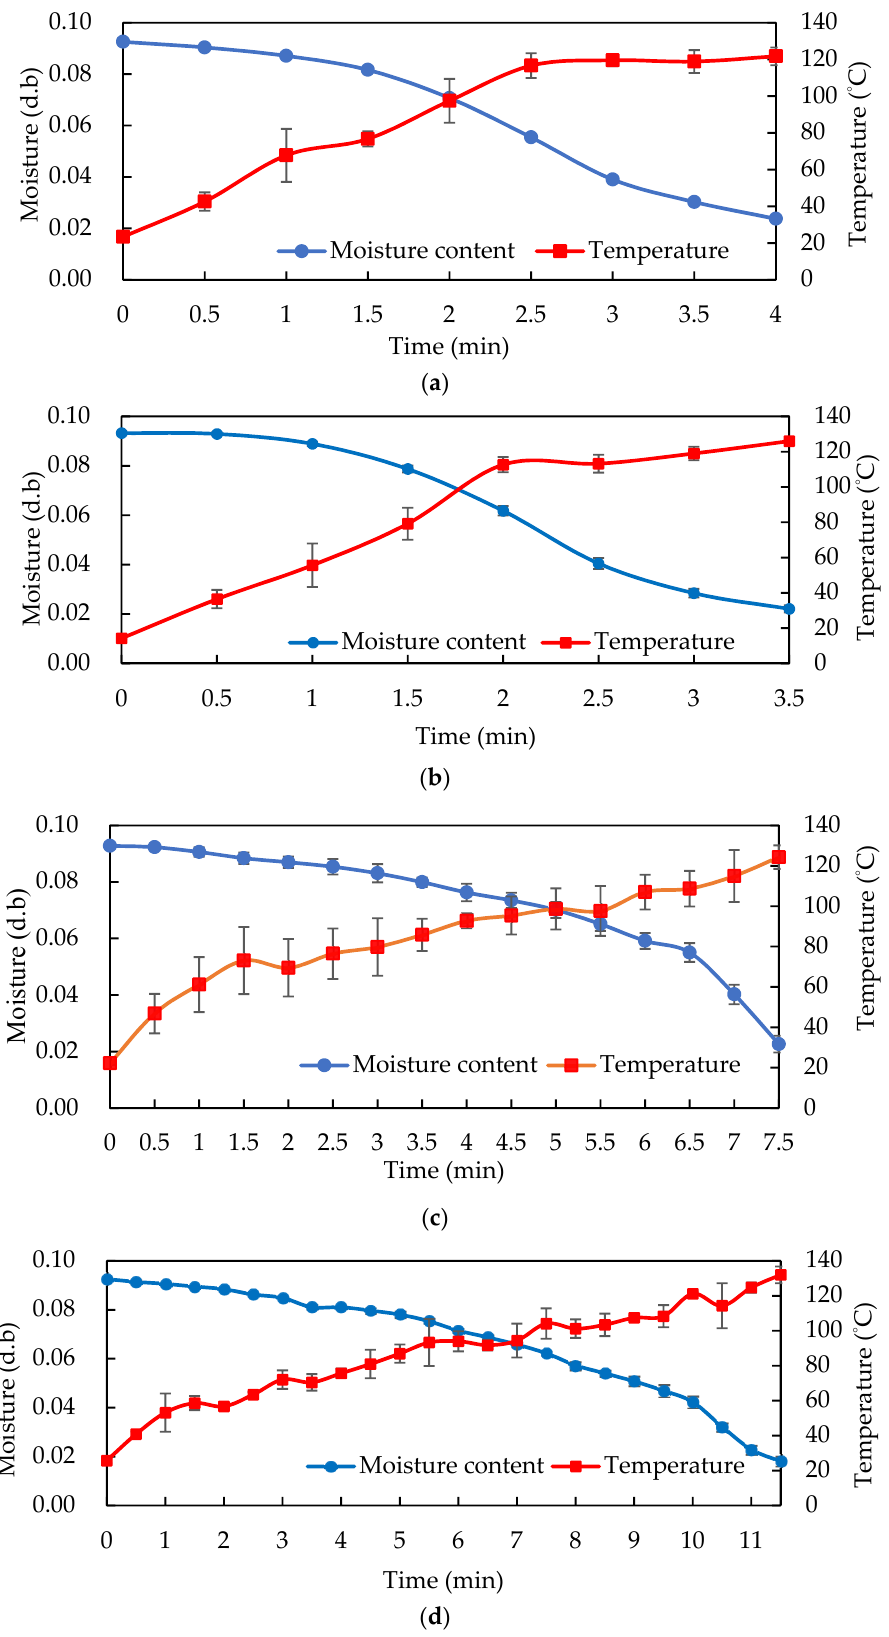
Figure 3. The drying and temperature curves of ( a ) 0.5, ( b ) 1, ( c ) 1.5, and ( d ) 2 kg almonds during 5 kW, 40.68 MHz batch RF roasting at 10 cm electrode gap. Data are expressed as mean ± S.D. ( n = 3).